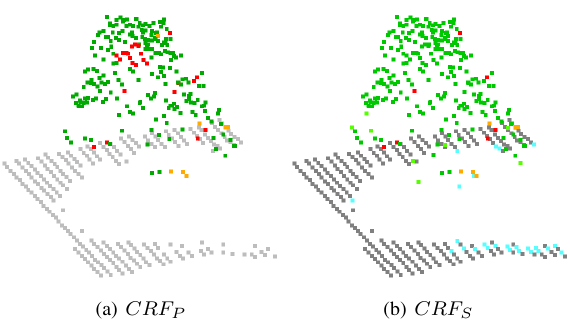
Figure 3. Example of a correction by CRF S . In 3(a) some tree points (green) are wrongly labelled as gable roof (red) in CRF P . In the segment-based case in 3(b) this problem is partly corrected.